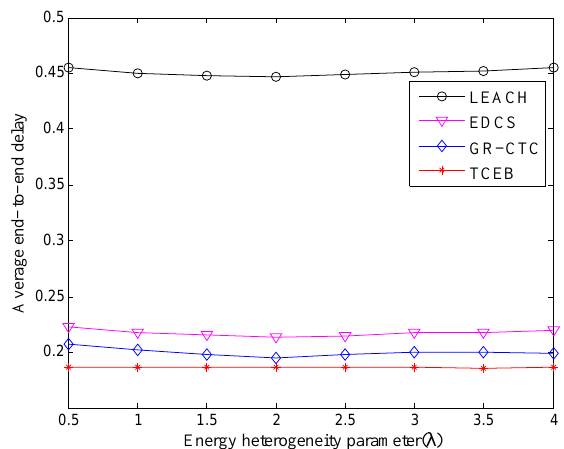
Figure 12. The comparison of average end-to-end delay under different energy heterogeneity factor ( n = 200 ) .